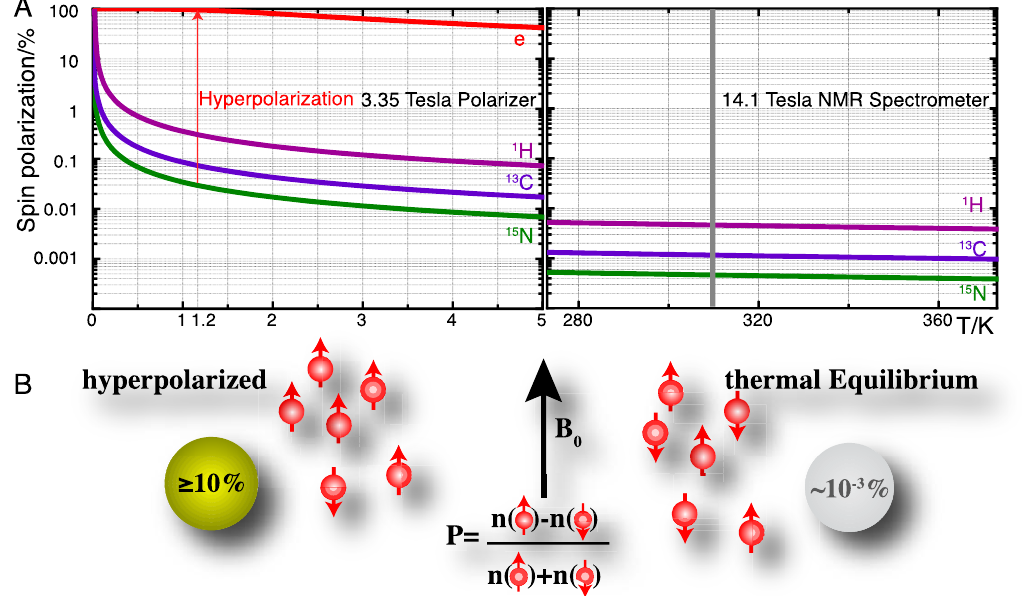
Figure 1. ( A ) Spin polarizations of electrons (―e‖), 1 H, 13 C and 15 N nuclei in a 3.35 Tesla DNP polarizer near liquid helium temperature, compared to spin polarizations of 1 H, 13 C and 15 N in a 14.1 Tesla (600 MHz) spectrometer at 273–373 K. An approach to hyperpolarization is the transfer of electron spin polarization to nuclei near 1.2 K prior to dissolution of the hyperpolarized sample in hot aqueous buffer; ( B ) resultant hyperpolarized samples in aqueous solutions achieve spin polarizations P that are ~3–4 orders of magnitude enhanced relative to the thermal equilibrium polarization in an NMR